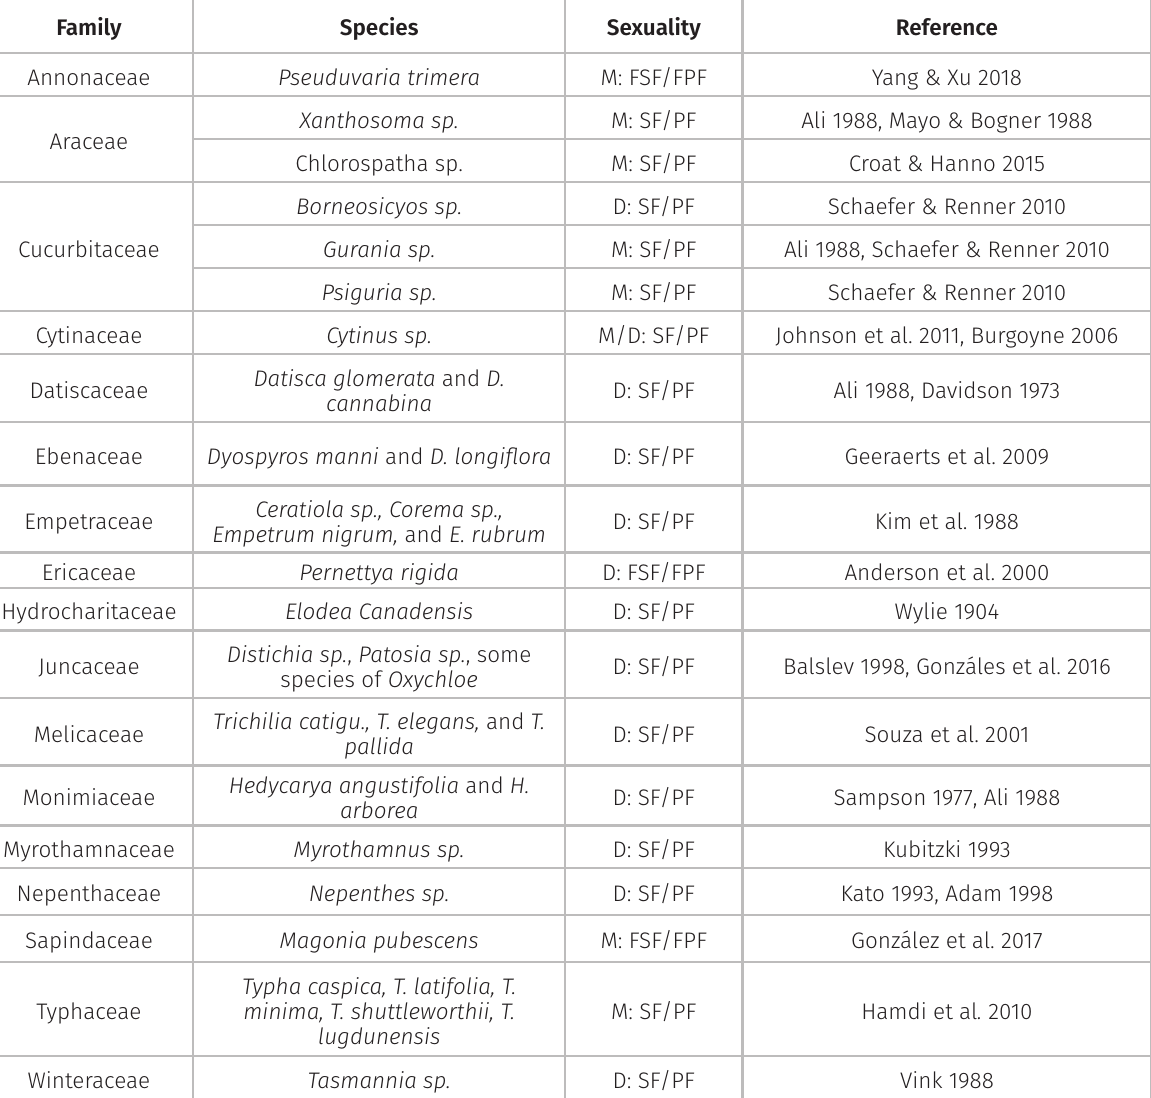
Table IV. Species with imperfect flowers and pollen release in the form of permanent tetrads. Abbreviations: PF: perfect flower; D: dioecious; PF: pistillate flower; FPF: Functional pistillate flower; FSF: functional staminate flower; M: monoecious; SF: Staminate